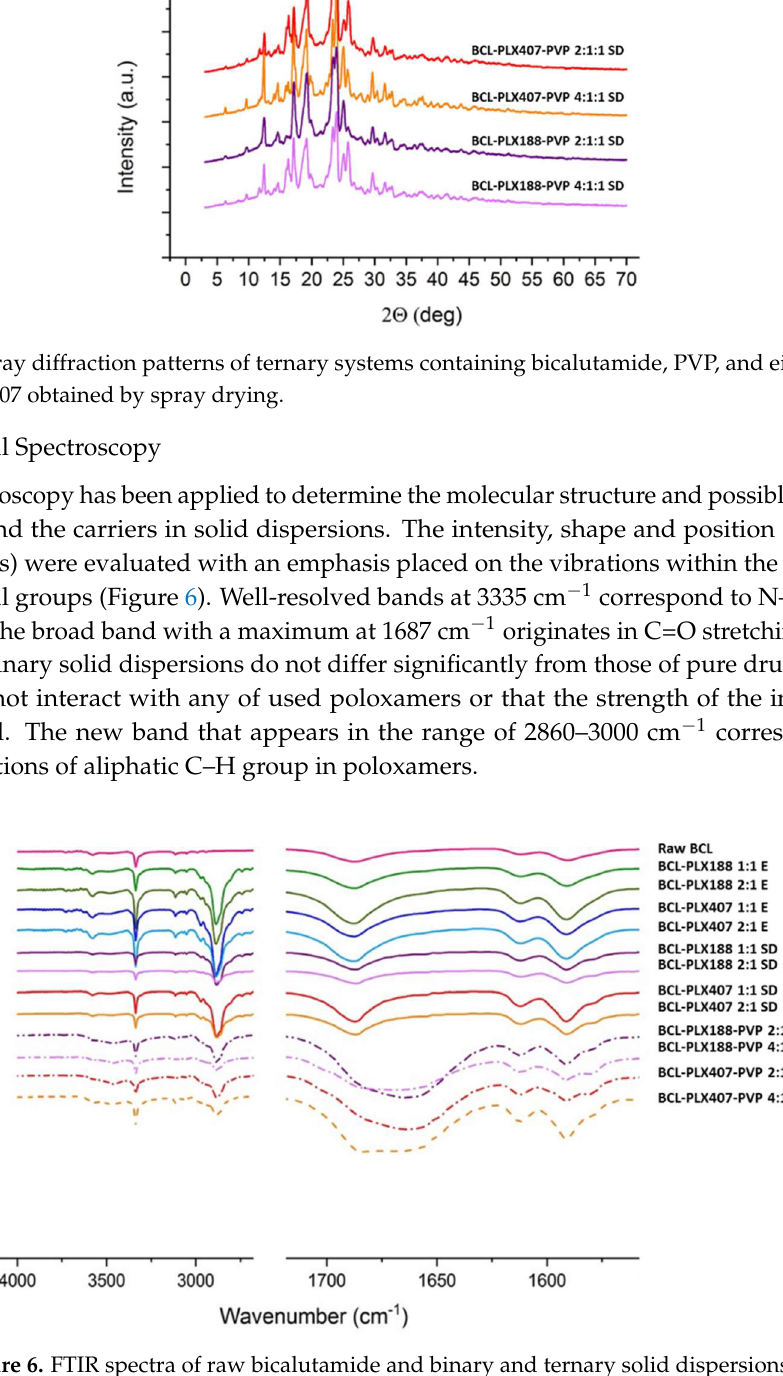
Figure 6. FTIR spectra of raw bicalutamide and binary and ternary solid dispersions.